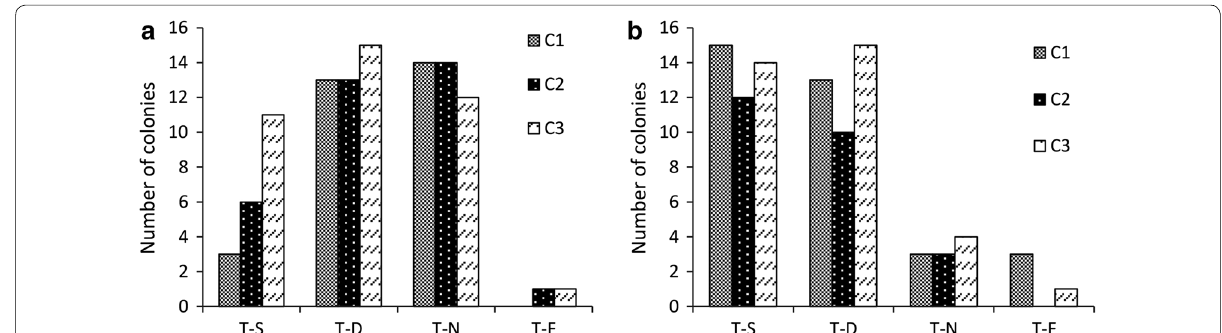
Fig. 3 Graphs showing the number and patterns of bacterial colonies generated on the kanamycin-supplemented plate during the deletion of ncRNA31 from P. stutzeri A1501 using the VFAE protocol. a Number of colonies appearing when the VFAE original protocol was applied to the target locus ncRNA31 (represented in three DNA cassettes with different lengths C1 – C3 ). b Number of colonies appearing when the enhanced VFAE proto- col was applied to the target locus ncRNA31 (represented in three DNA cassettes C1 – C3 ). T-S, single crossover mutant; T-D, double crossover mutant; T-N, wild-type pattern. T-F, failed